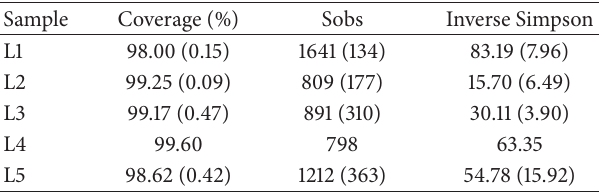
Table 3: 𝛼 -Diversity analysis for archaeal community of the five sediment layers (standard deviations of replicates are in